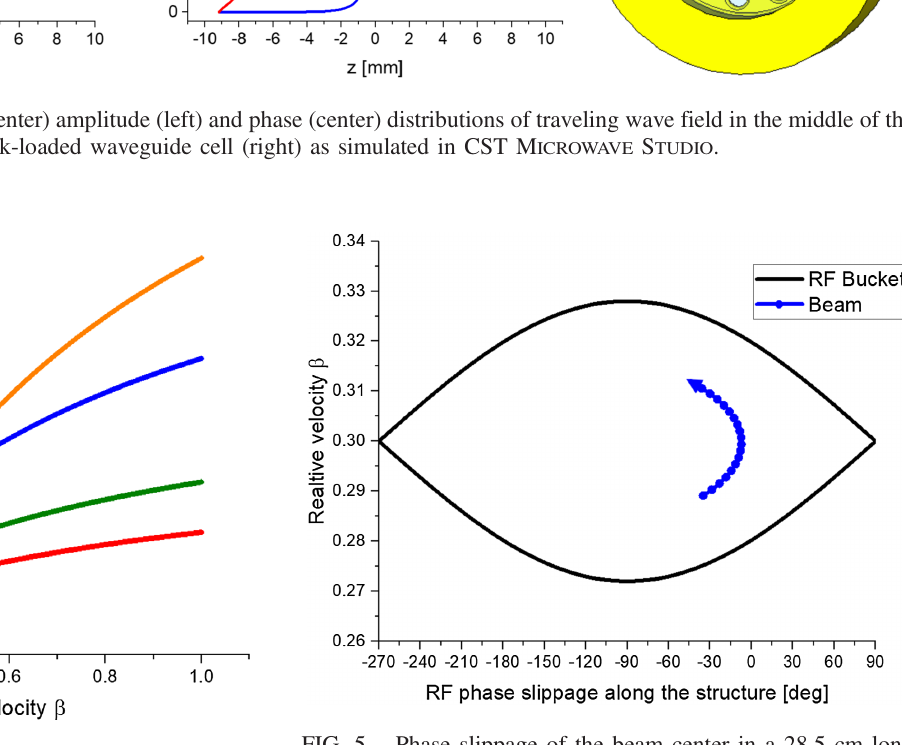
FIG. 3. Effective shunt impedance of a π -mode pillbox cavity as a function of phase velocity for different frequencies. Beam apertures are 6 mm.